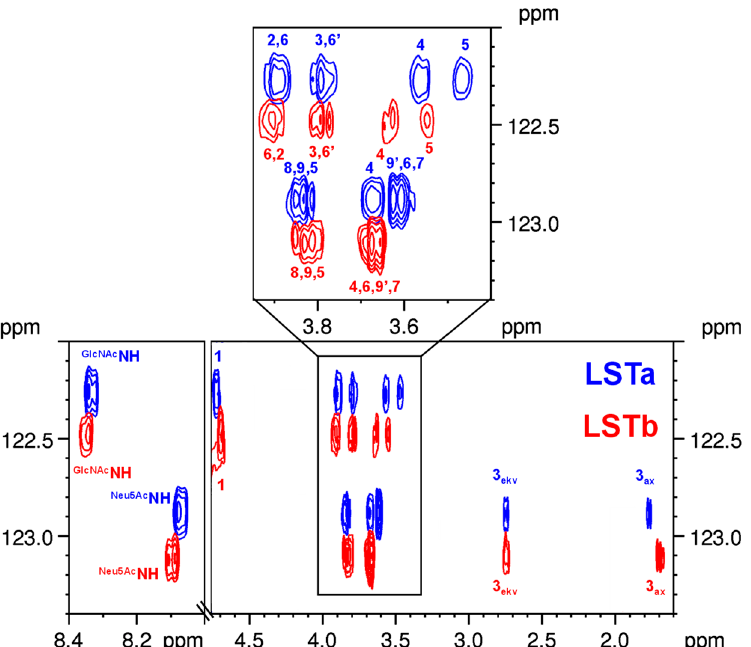
Figure 5. Overlaid 1 H- 15 N HSQC-TOCSY spectra of isomeric LSTa and LSTb with the 1 H NMR assignment of their GlcNAc and Neu5Ac moieties (The full spectra can be seen in Figure S80).